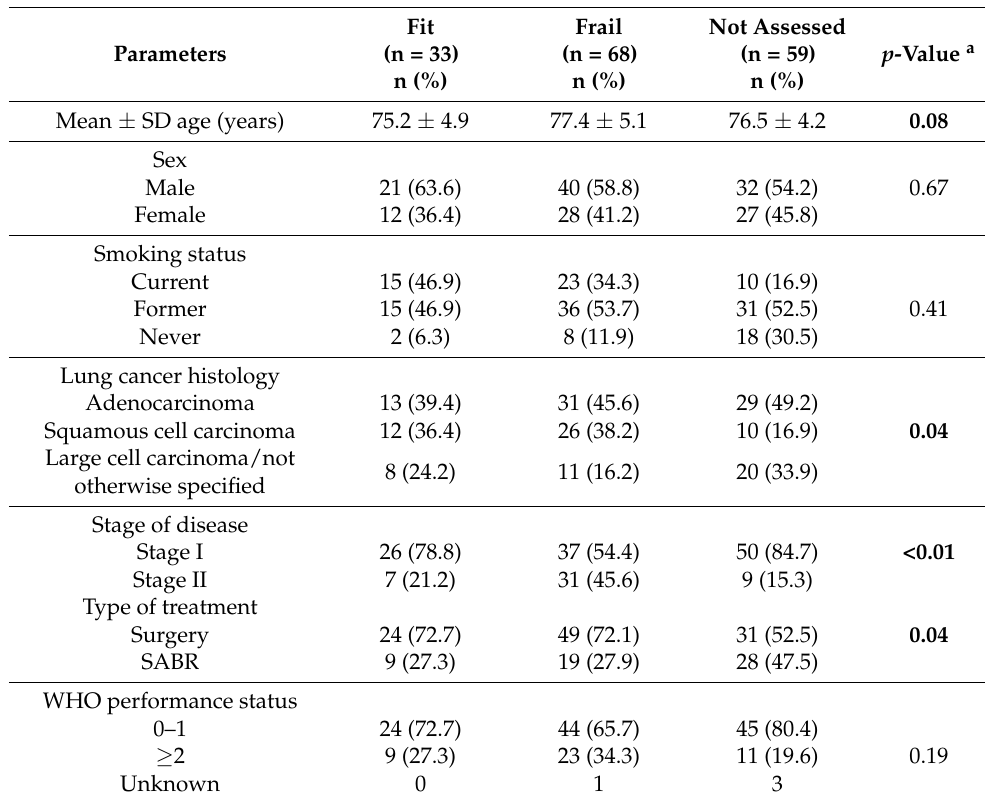
Table 2. Overview of patient, tumor, and treatment characteristics in relation to the pretreatment comprehensive geriatric